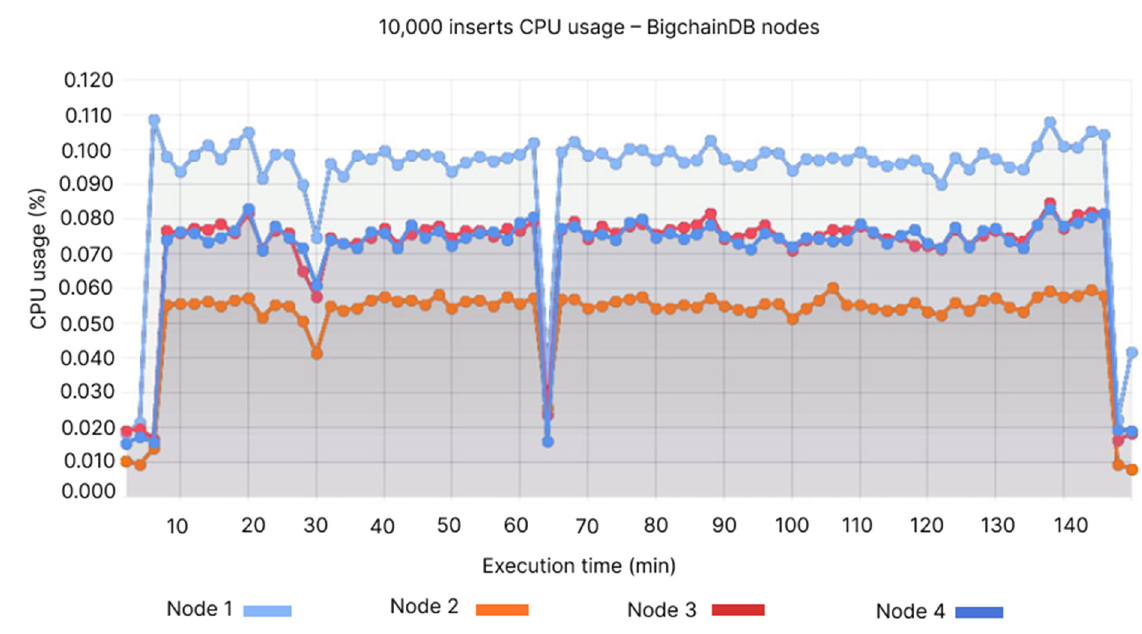
Figure 14. 10,000 inserts CPU usage—BigchainDB nodes.